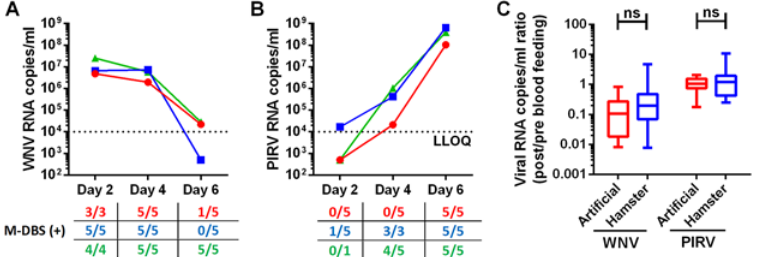
Fig 3. Detection of viral RNA from infected hamsters is not significantly different than from artificial bloodmeals. Hamsters were infected with (A) WNV or (B) PIRV and blood was collected on days 2, 4 and 6 post infection to determine viral RNA copies/ml (n = 3 represented by different colors shown in graphs). Prior to blood collection, the hamsters were offered to mosquitoes as bloodmeals. The tables show the number of mosquito dried blood spots (M-DBS) that were positive for virus-specific RNA, determined by qRT-PCR titers greater than the lower limit of quantification (LLOQ), per M-DBS tested for each hamster and time point. Table text colors represent different hamsters offered as bloodmeals and correspond to the colors in the graphs. (C) Ratios of viral RNA titers (means with min to max whiskers) post blood feeding (M-DBS) to pre blood feeding (2 μ l blood applied to FTA cards) were used were used to determine the recovery of viral RNA from mosquito bloodfeeding. The post/pre blood feeding ratios between virus-spiked artificial and infected hamster bloodmeal sources were compared using unpaired t tests and were not